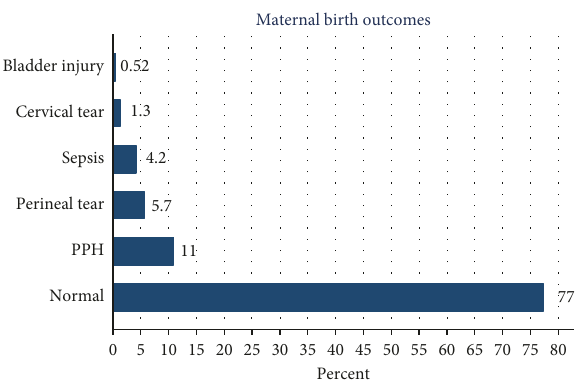
Figure 1: Percentage of maternal birth outcomes of postnatal mothers, Debre Tabor Hospital,